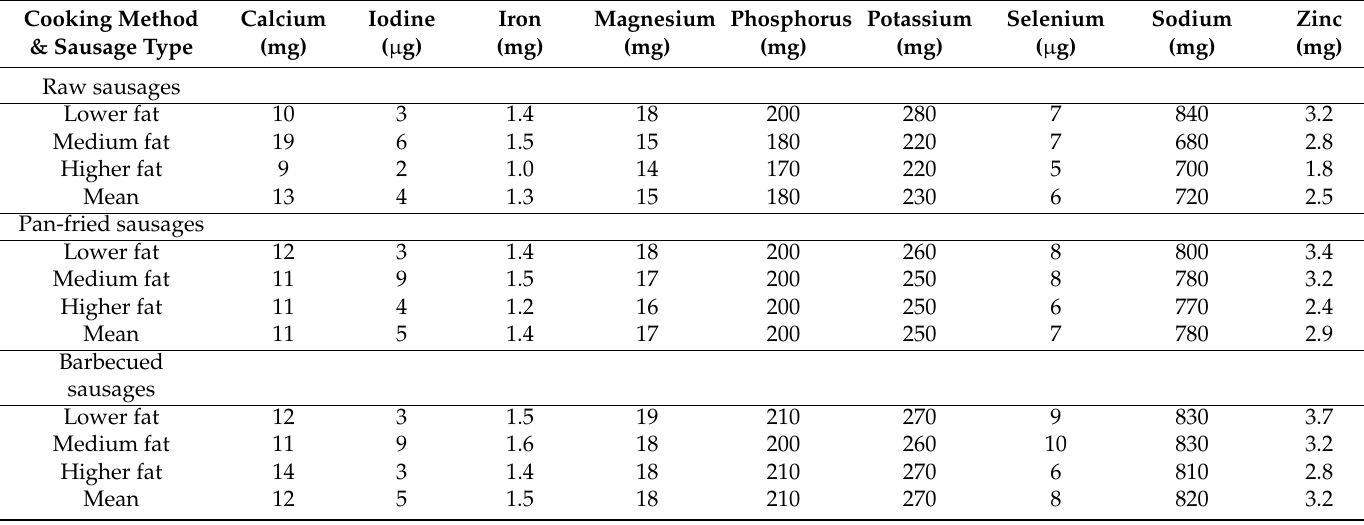
Table 6. Mineral content of composite samples of beef sausages 1 grouped according to fat content; raw, pan-fried without oil and barbecued. All values are expressed per 100 g edible